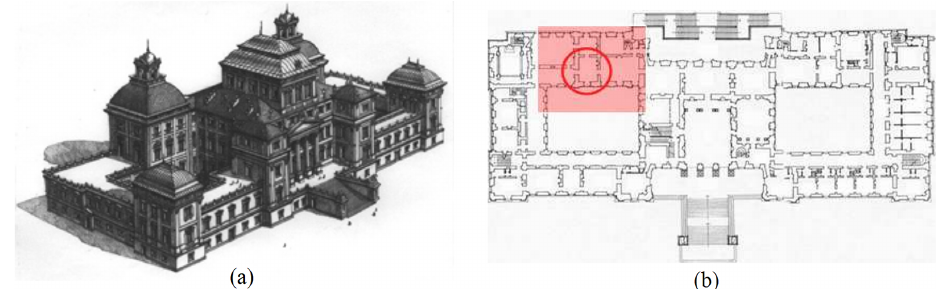
Figure 1. Axonometric view of the castle in the contemporary configuration (a) ; plan of the first floor: localization of the monitored bearing structure inside the thermal bath (b) .